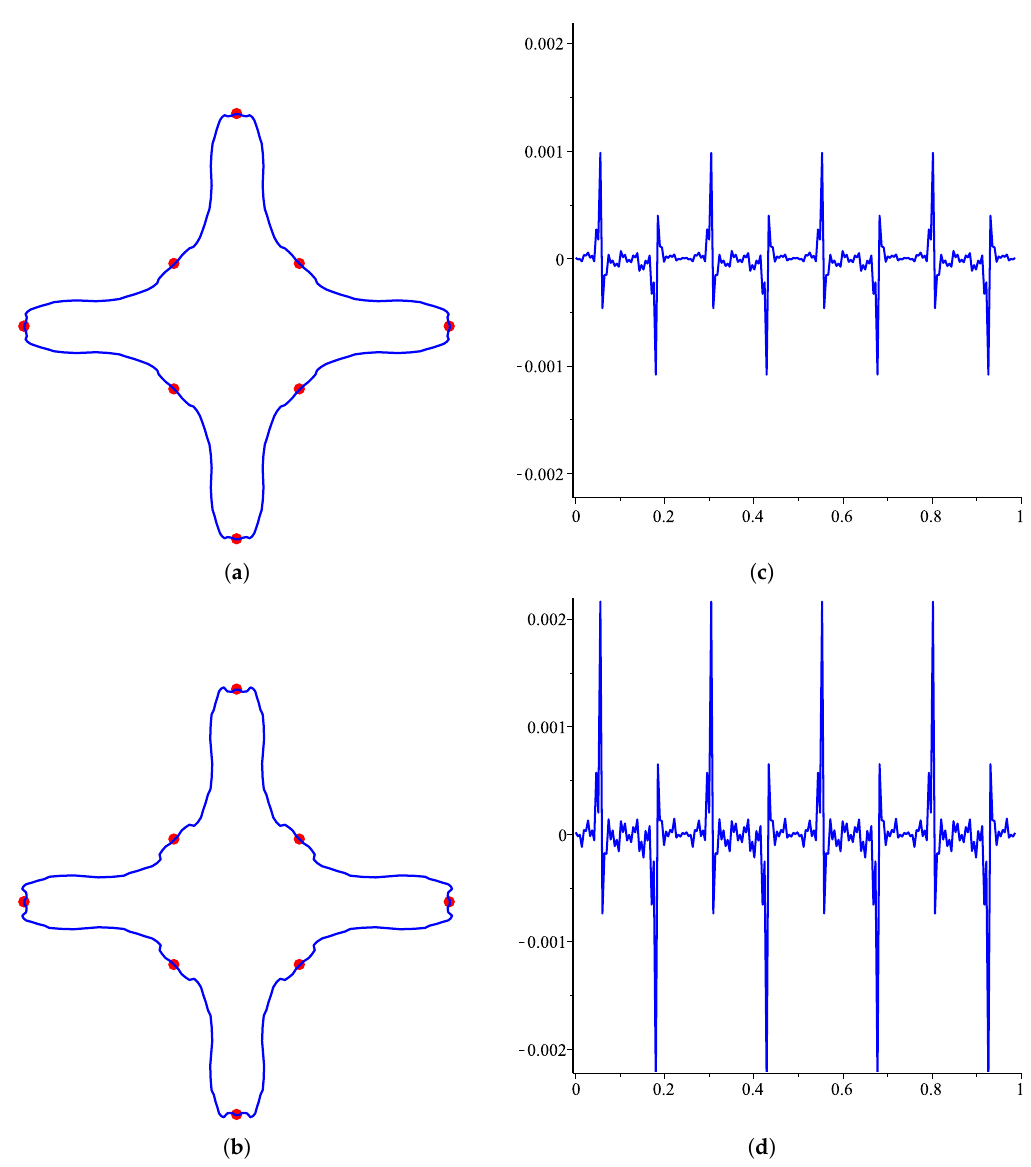
Figure 4. Results for various choices of the parameter u are shown on the left together with their corresponding curvature on the right. From top to bottom: u = 0.0076 and 0.0077. ( a ) Limit curve at u = 0.0076; ( b ) Limit curve at u = 0.0077; ( c ) Curvature plot of ( a ); ( d ) Curvature plot of ( b